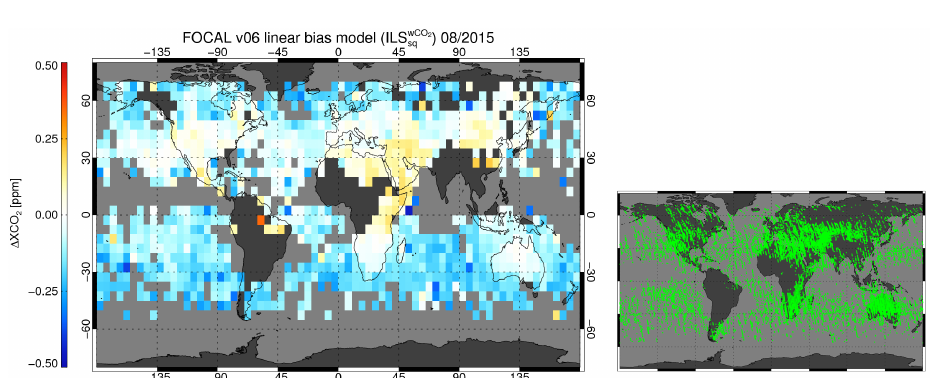
Figure 11. FOCALv06 bias pattern of the linear bias model (Equation (7)) at the example of August 2015 ( left ) and sampling of soundings used to determine the linear bias model ( right